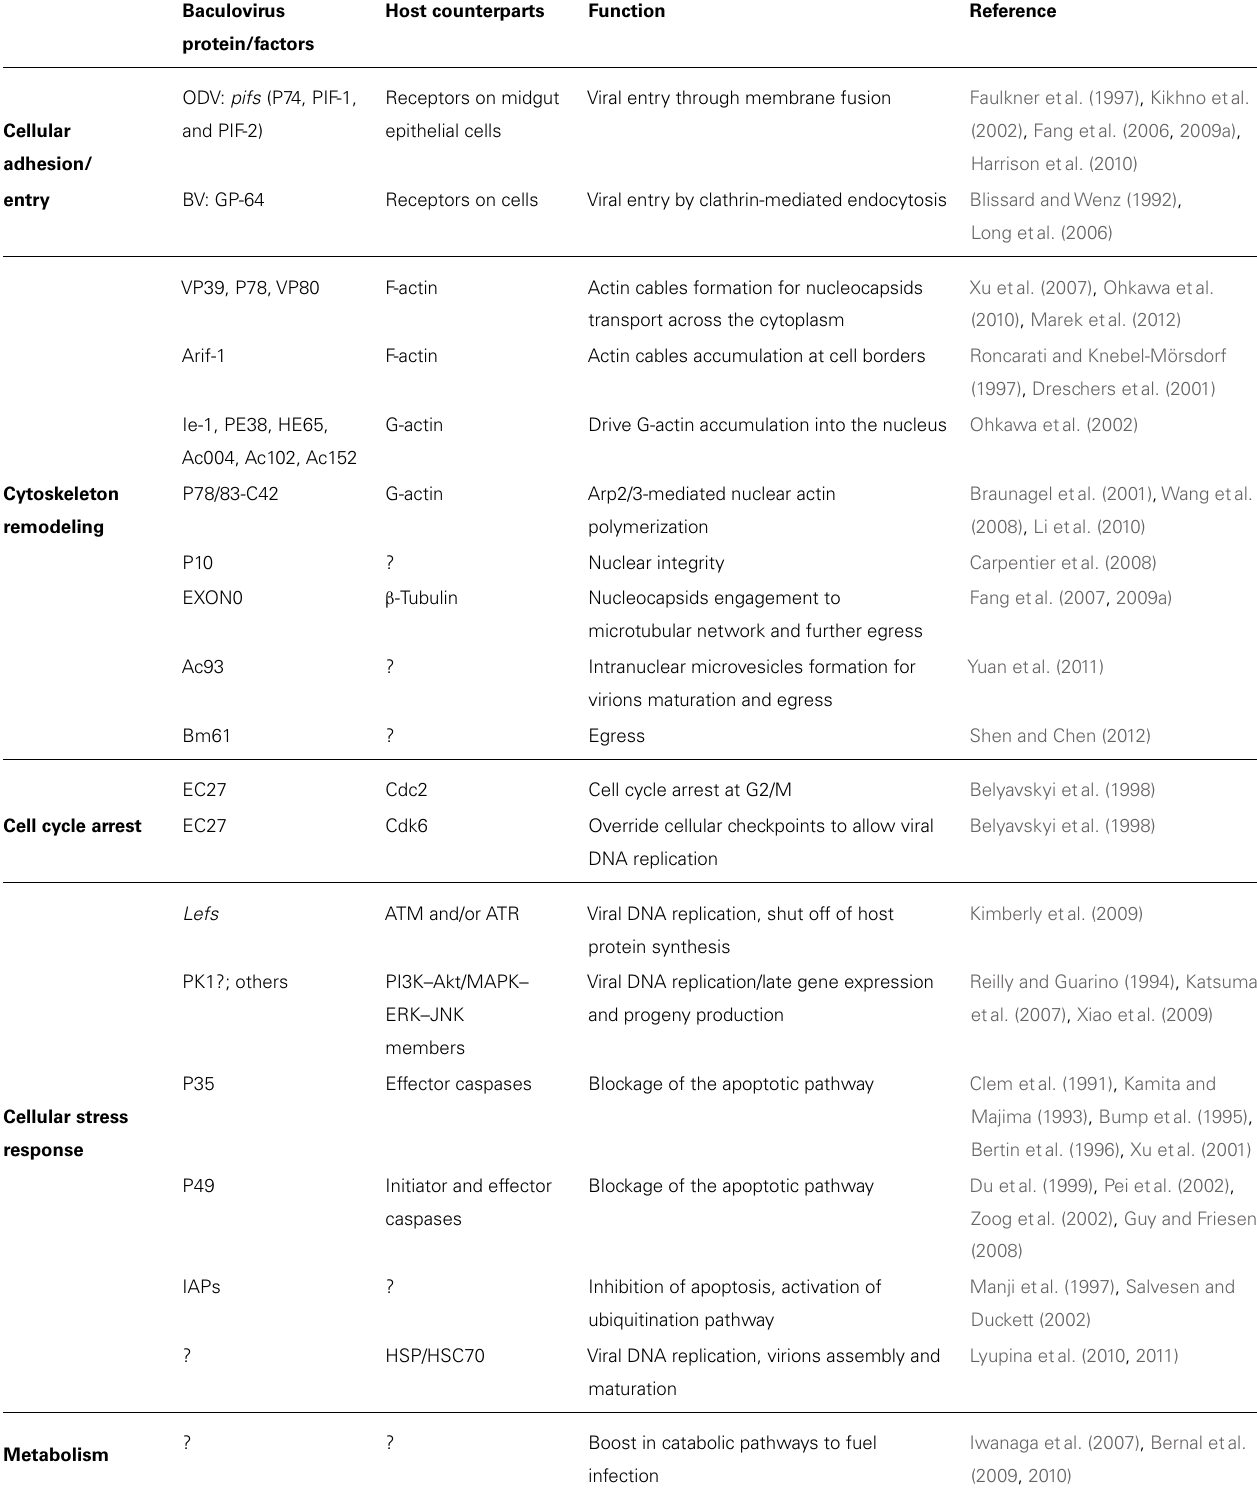
Table 1 | Baculovirus genes affecting host